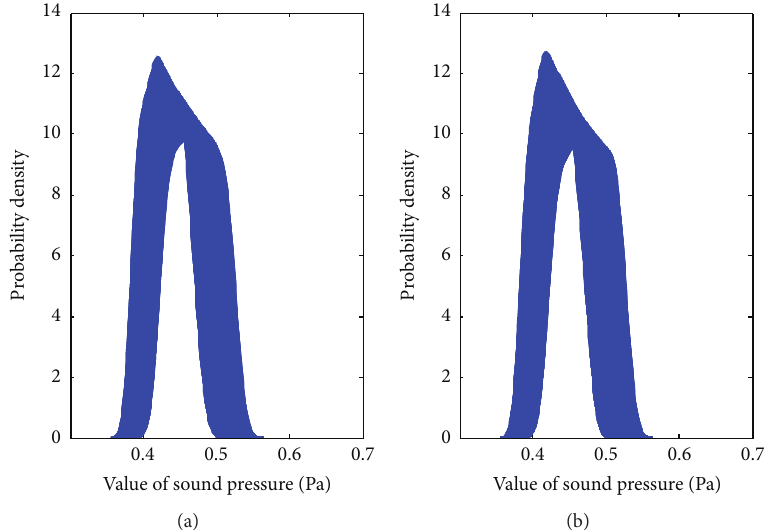
Figure 4: The lower and upper bounds of the response probability density of node 𝑅1 calculated by (a) MCS and (b) PCRS.